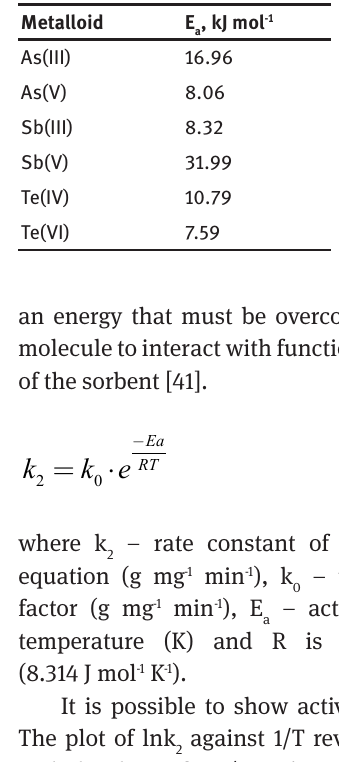
Table 3: Calculated activation energy for Fe-modified peat sorbing